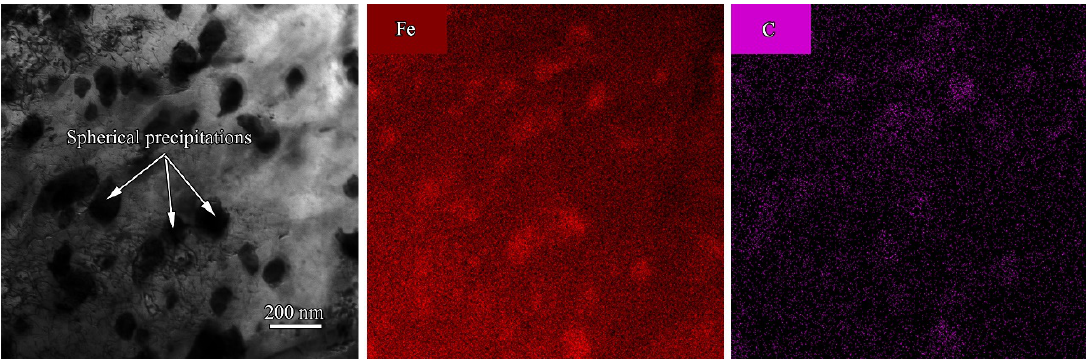
Figure 12. Morphology of precipitations and elements distribution of sample 1.